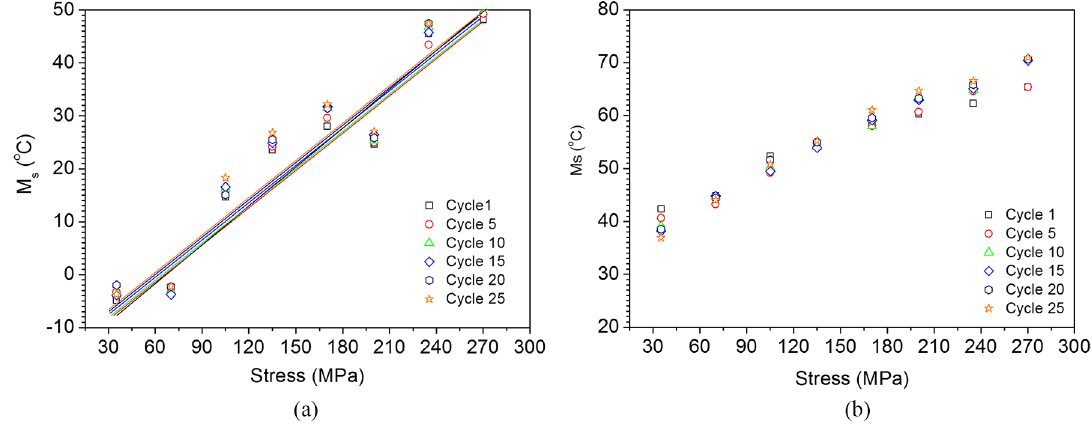
Figure 9. Variations in Ms temperatures due to the stress applied during the thermomechanical cycles.